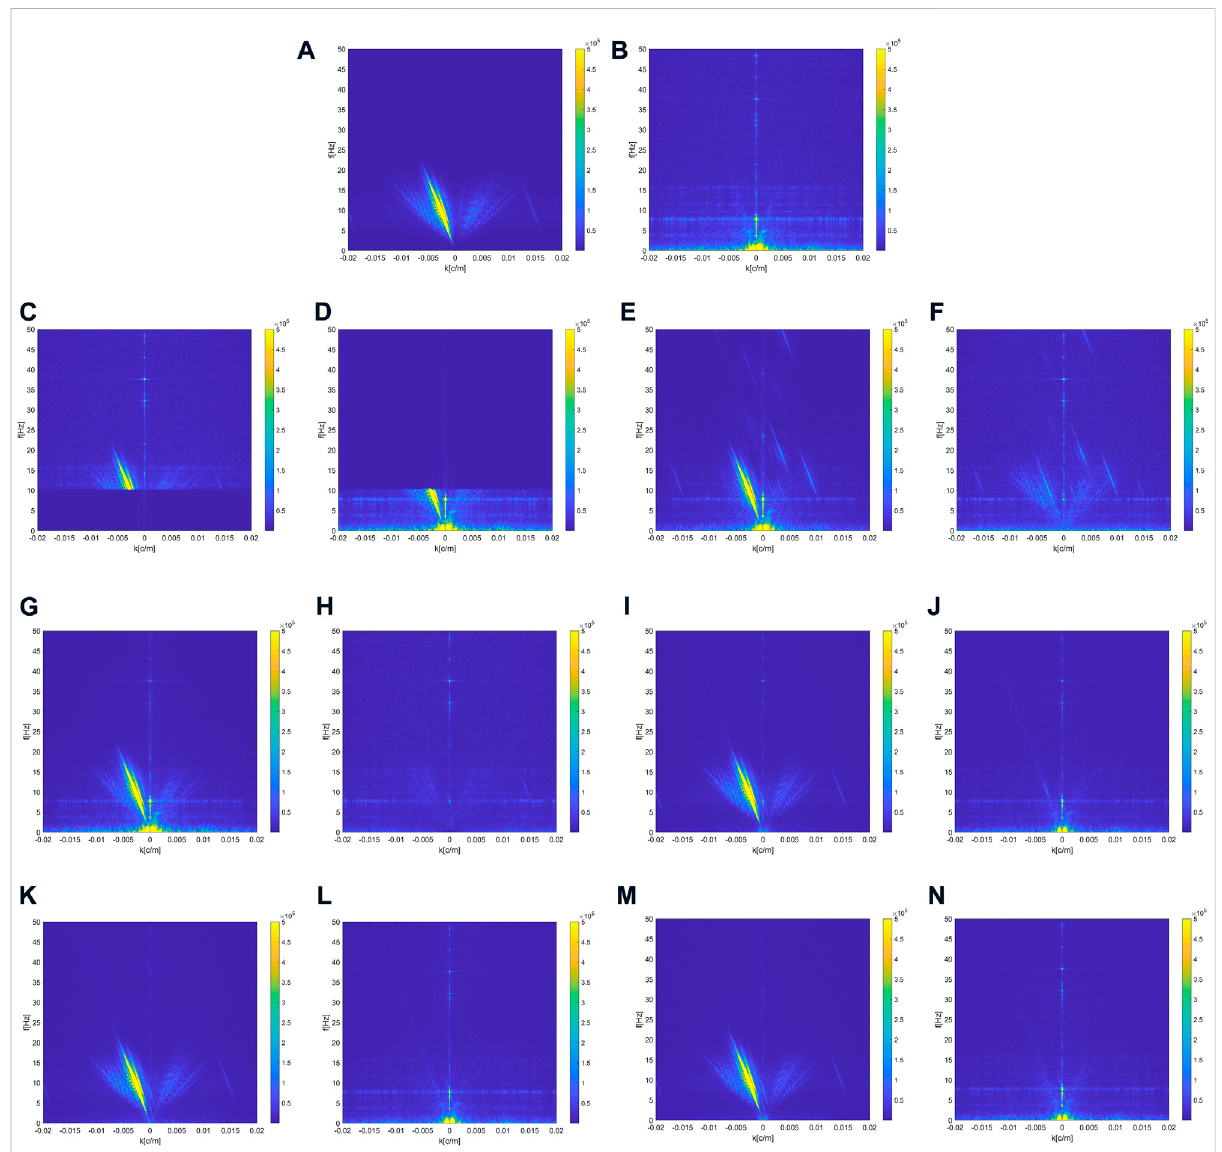
FIGURE 7 F-Kdomainanalysisforthedenoisingresultsofdifferentmethods. (A,B) F-Kspectrumofthepurerecordandnoisedata. (C,D) F-Kspectraofthe denoising results and predicted noise of Band-pass fi ltering. (E,F) F-K spectra of the denoising results and predicted noise of Wavelet Transform fi ltering. (G,H) F-K spectra of the denoising results and predicted noise of WNNM. (I,J) F-K spectra of the denoising result and predicted noise of DnCNN (K,L) F-K spectra of the denoising result and predicted noise of U-Net (M,N) F-K spectra of the denoising result and predicted noise of